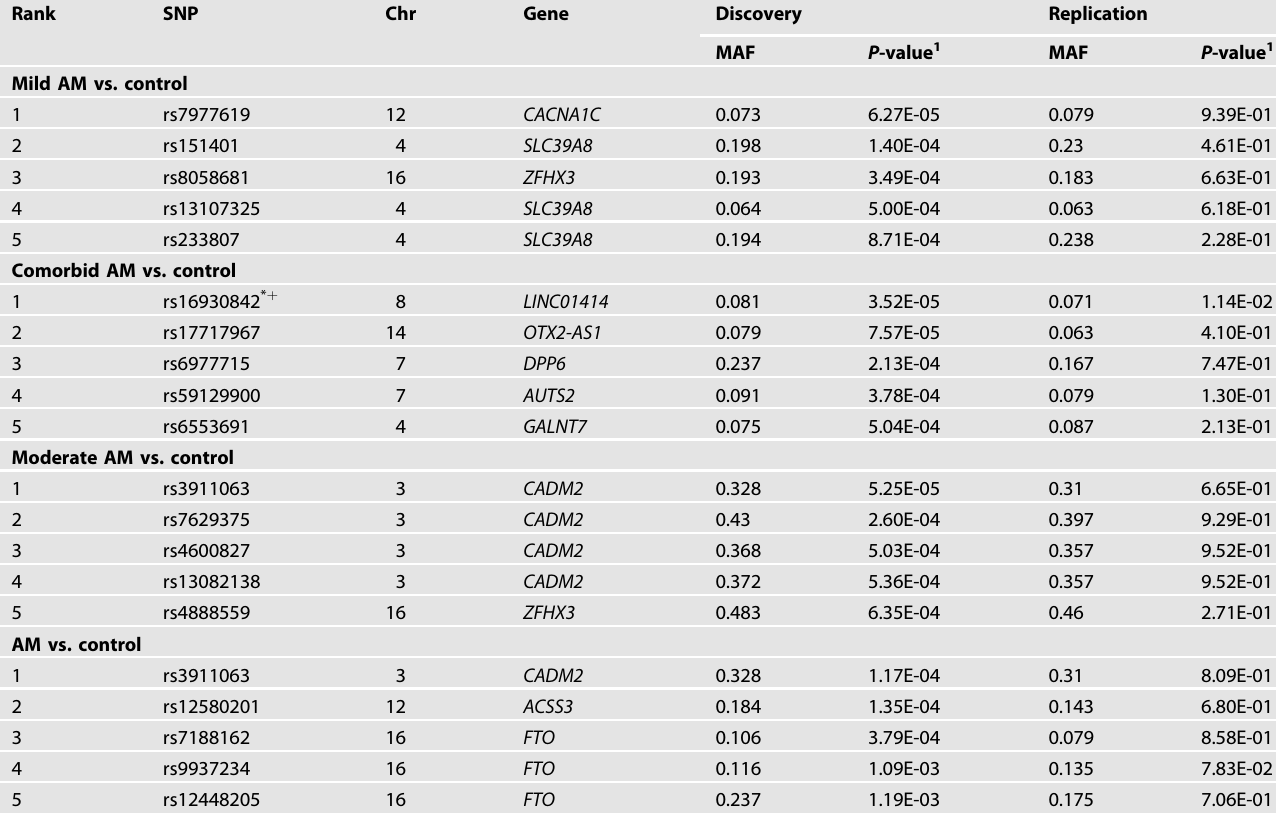
Table 2. Top SNPs of main effect on different traits (ranked by P